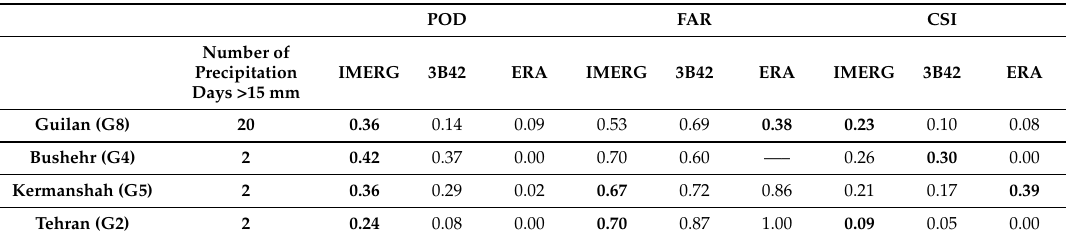
Table 18. Spatially averaged POD, FAR and CSI metrics for precipitation above 15 mm/day. POD FAR CSI Number of Precipitation IMERG 3B42 ERA IMERG 3B42 ERA IMERG 3B42 ERA Days >15 mm Guilan (G8) 20 0.36 0.14 0.09